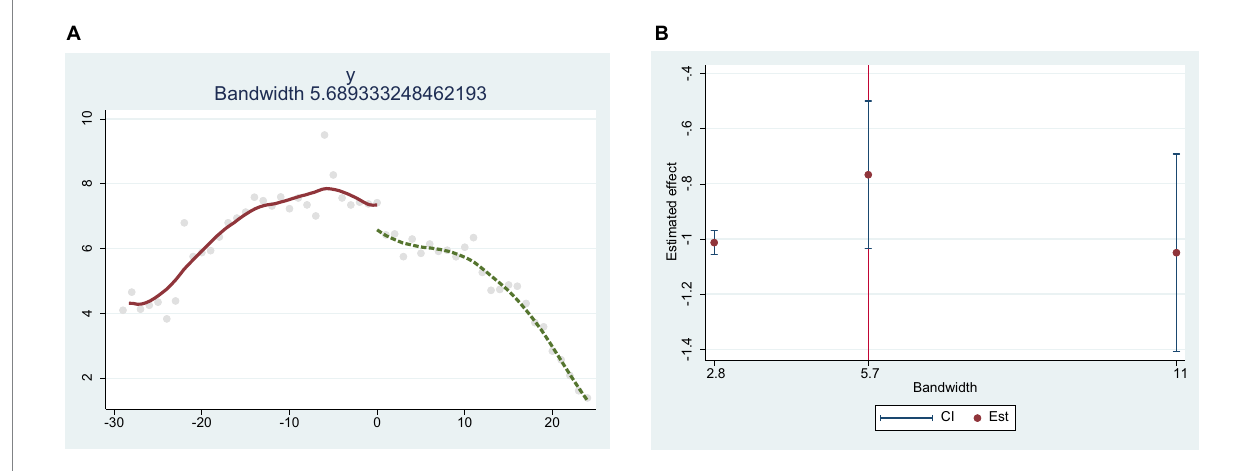
FIGURE 4 Breakpoint regression between emergency disaster prevention facilities and the number of infected people in Wuhan. (A) is breakpoint regression; (B) is bandwidth